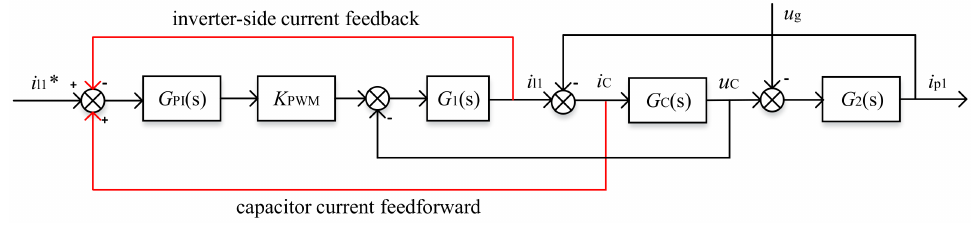
Figure 5. Capacitor current feedforward and inverter-side current feedback control block